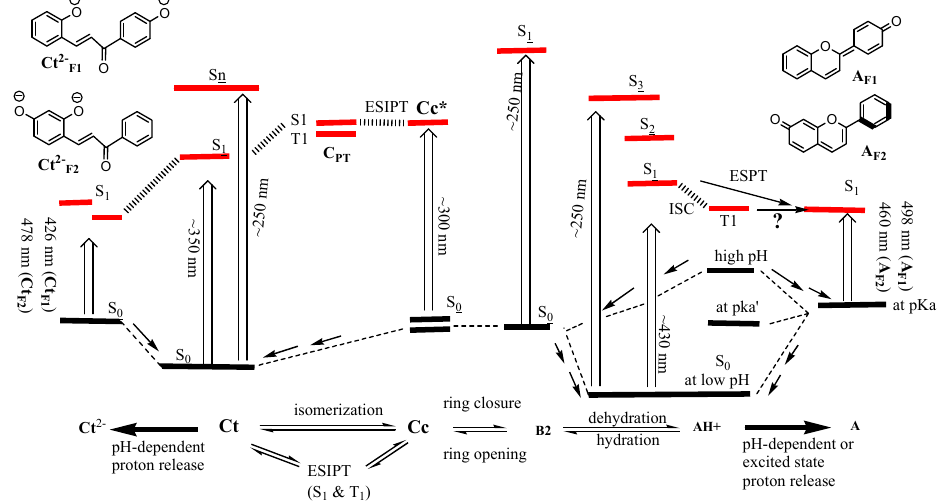
Figure 4. Schematic representation for relative energy levels and approximate absorptions of AH + and CB in pH range between 1 and 7. Ct is generally most stable at a pH greater than pKa ′ , whereas AH + is most stable in a more acidic pH solution than pKa ′ .